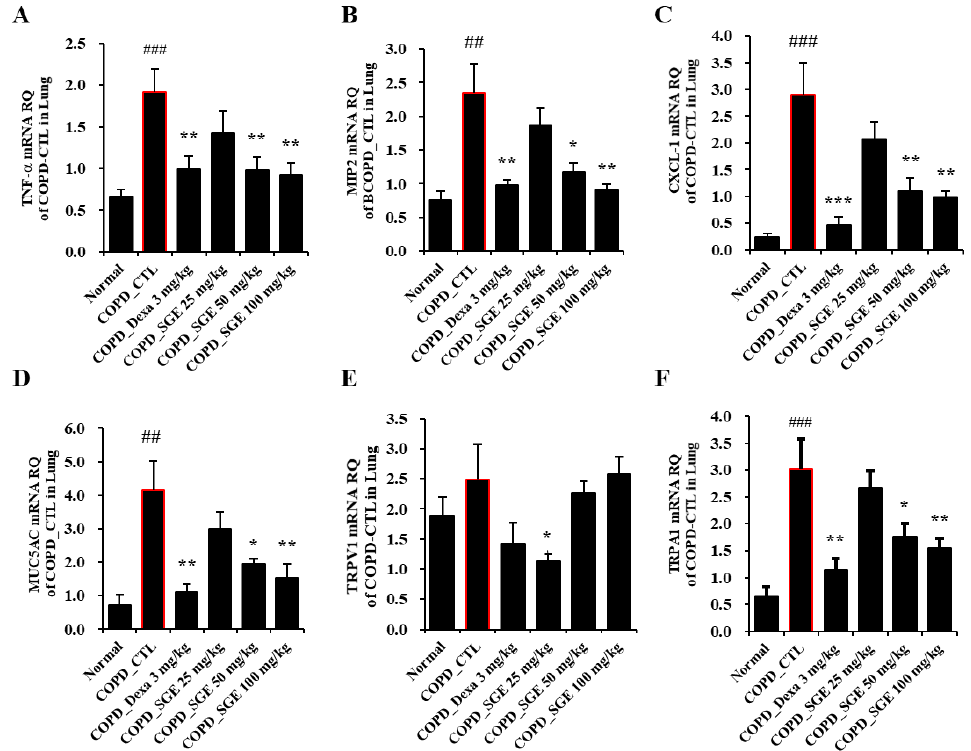
Figure 5. Effects of SGE on the expression of genes for TNF- α , MIP2, CXCL1, MUC5AC, TRPV1, and TRPA1 in lung tissue of COPD-induced mice. Expression of ( A ) TNF- α , ( B ) MIP2, ( C ) CXCL-1, ( D ) MUC5AC, ( E ) TRPV1, and ( F ) TRPA1 genes was determined by RT-qPCR in lung tissue of COPD-induced mice. The data are presented as means ± SEM (n = 6 mice) for individual mice. ## p < 0.01, ### p < 0.001 compared to normal, and * p < 0.05, ** p < 0.01, and *** p < 0.001 compared to control. Dexa, dexamethasone.